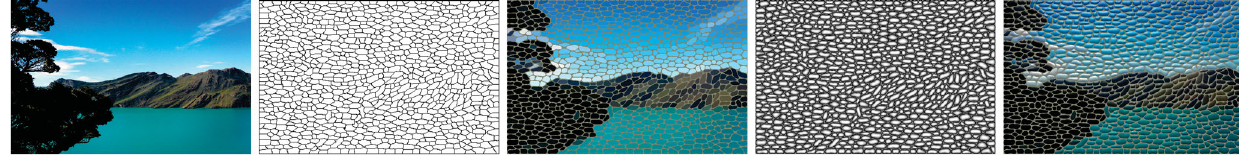
Fig. 2 An image progressing through our system. Left to right: input, segmentation, boundary smoothing, pebble geometry,